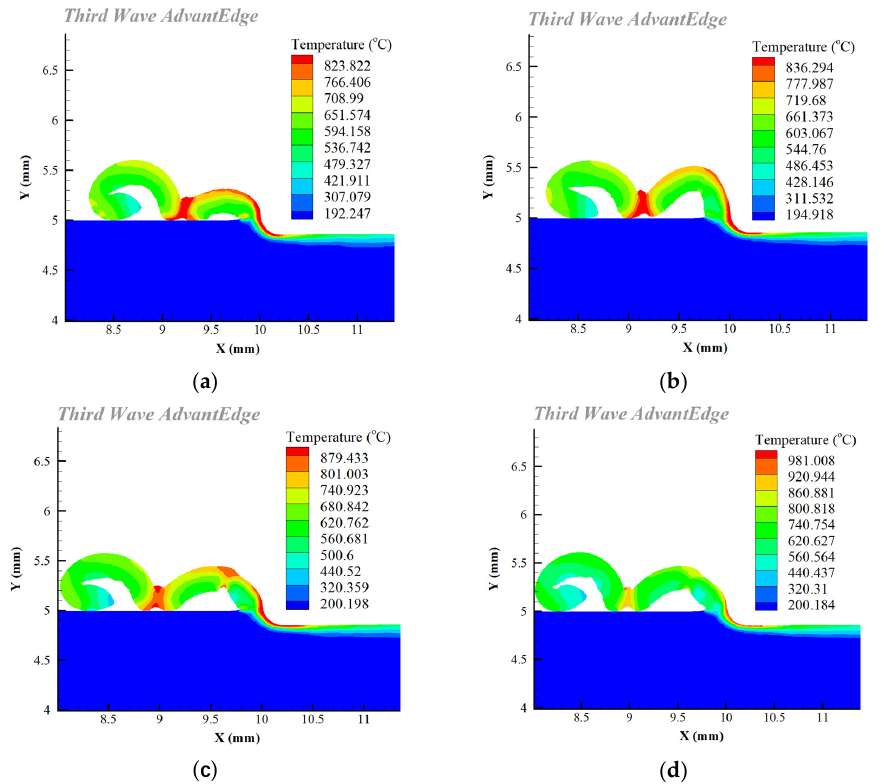
Figure 4. Simulation results for cutting temperature: ( a ) VB = 0 mm; ( b ) VB = 0.1 mm; ( c ) VB = 0.2 mm; ( d ) VB = 0.3 mm.